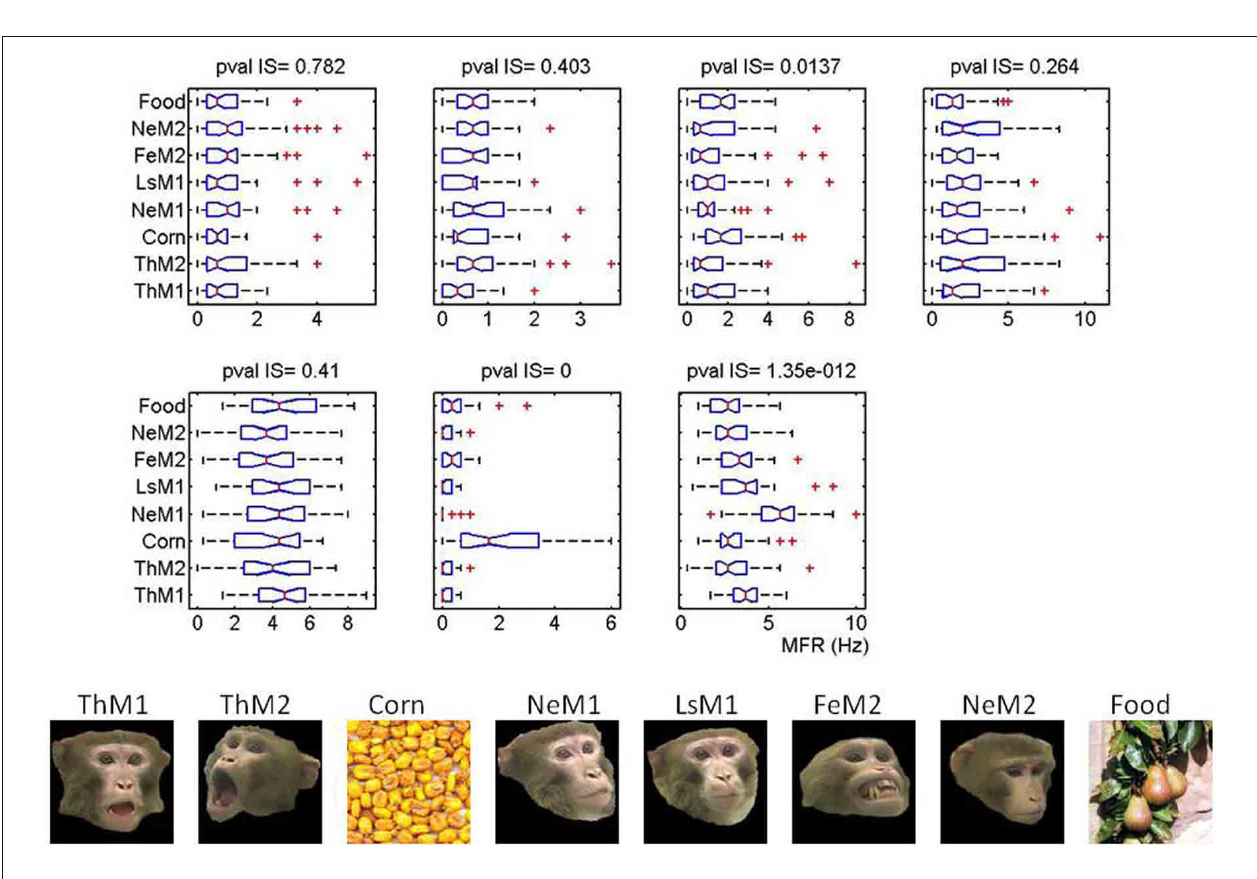
FIGURE 7 | Burst firing over salient locations is independent on the individual image selectivity for each cell. Image selectivity for the seven cells shown in Figure 5 . In the bottom panel we depict the images seen by the monkeys at this session. On top, we present the boxplots summarizing the distribution of firing rates as a function of the image.